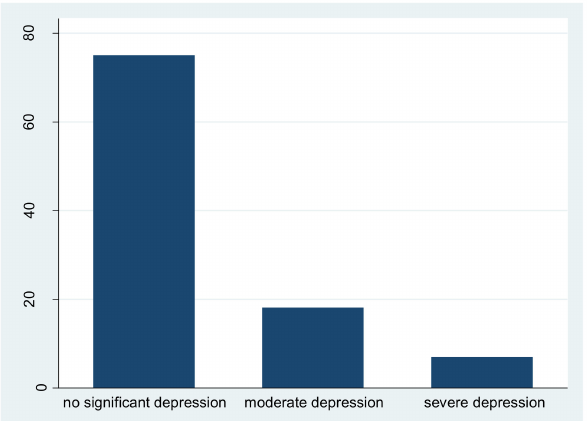
Figure 2. Mental health status of